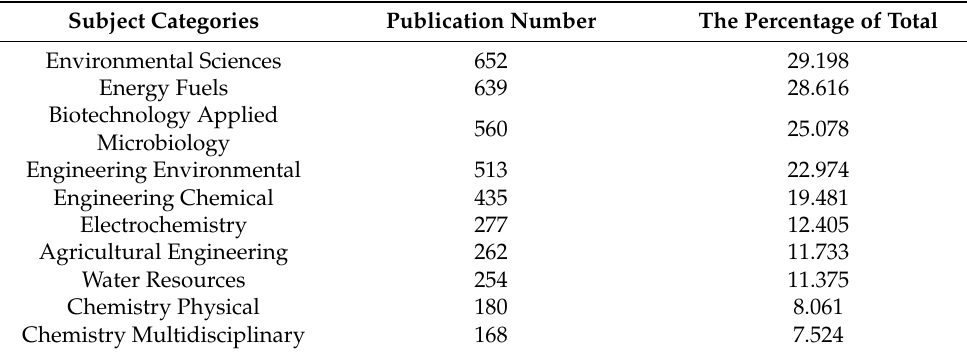
Figure 3. Document types on MFCs in wastewater treatment from 1995 to 2020. Table 1. The top 10 subject categories on MFCs in wastewater treatment.